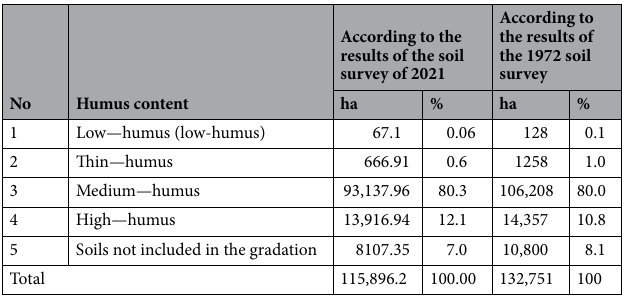
Table 1. Land areas by humus